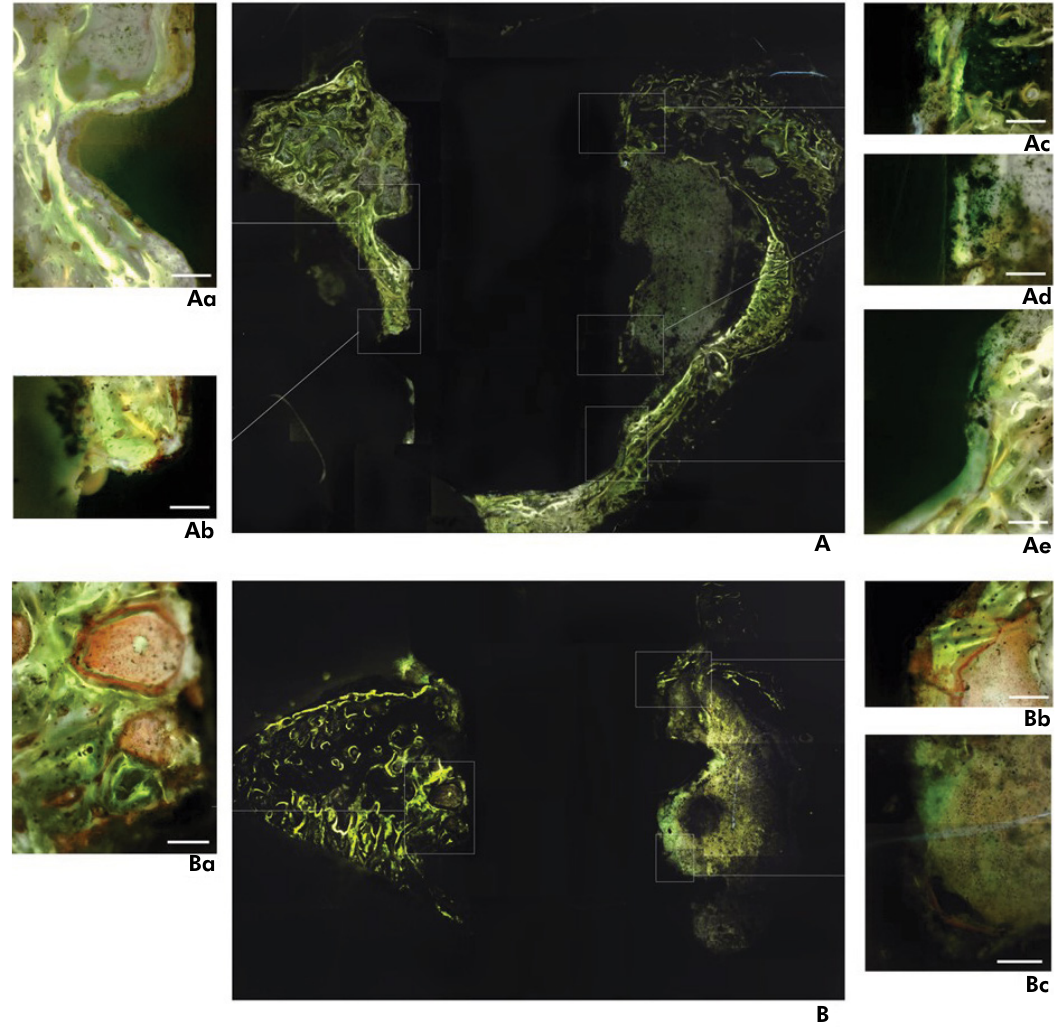
Figure 4. Fluorescence assessment of bone